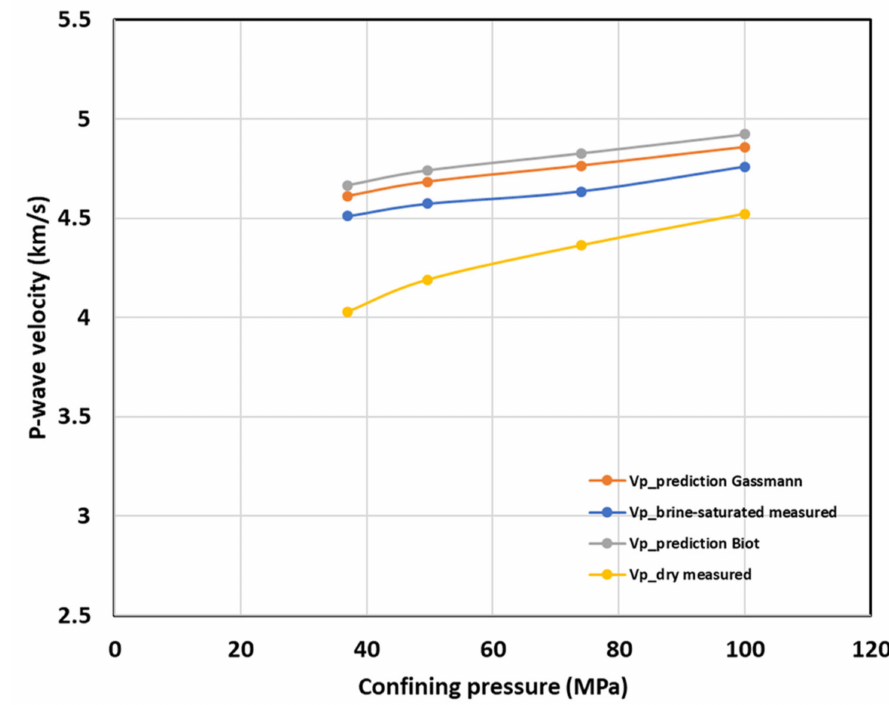
Figure 8. Tosaya (1982) P-wave velocity measurement of Cotton Valley shale. Similar to Figure 5, we have plotted the measured P-wave velocities. (The water-saturated P-wave velocity is in blue, the dry P-wave velocity is in yellow, the Biot P-wave velocity prediction is in gray, the Gassmann P-wave velocity prediction is in orange.) The predicted dispersion is within experimental